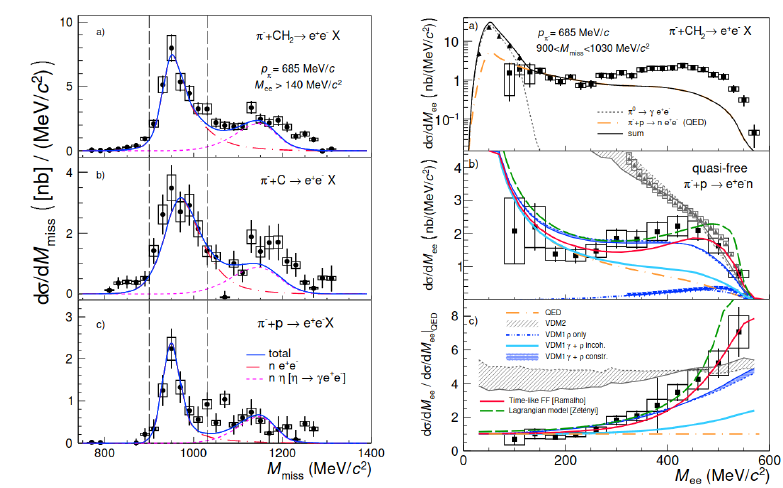
Figure 8. Left: E ffi ciency corrected missing mass distribution in the π − p system for a fixed pion-beam momentum of p = 0 . 695 GeV / c . Vertical lines indicate the missing mass window used to select the π − p → ne + e − channel. Right: d σ/ dM ee in the specified missing mass range. Data after subtraction of the π 0 Dalitz contribution is shown in comparison to model calculations in (b) and (c).